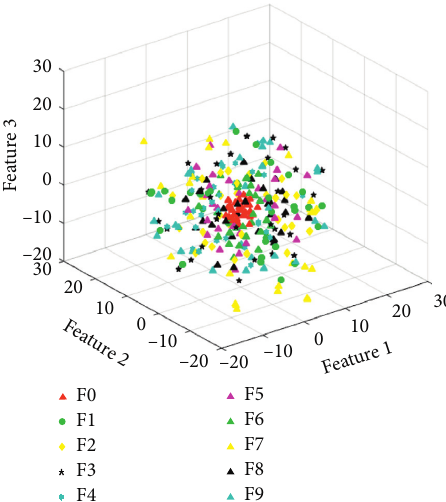
Figure 6: Visualization of raw vibration signals.